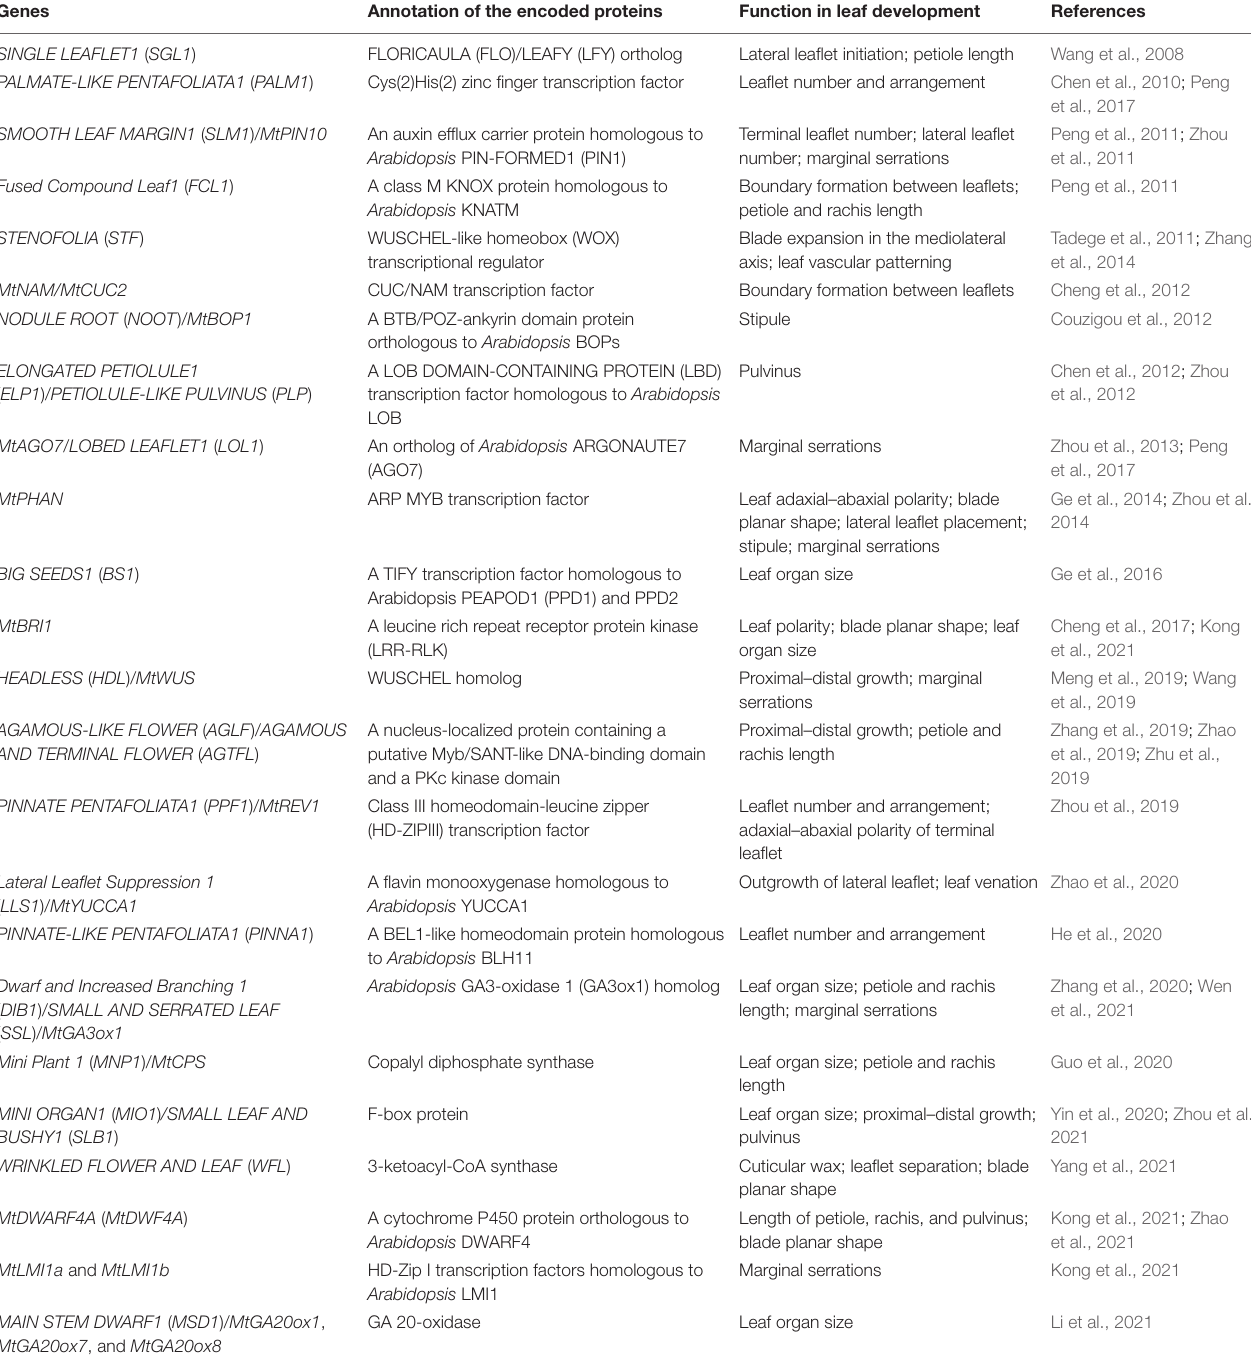
TABLE 1 | Functionally characterized genes involved in compound leaf